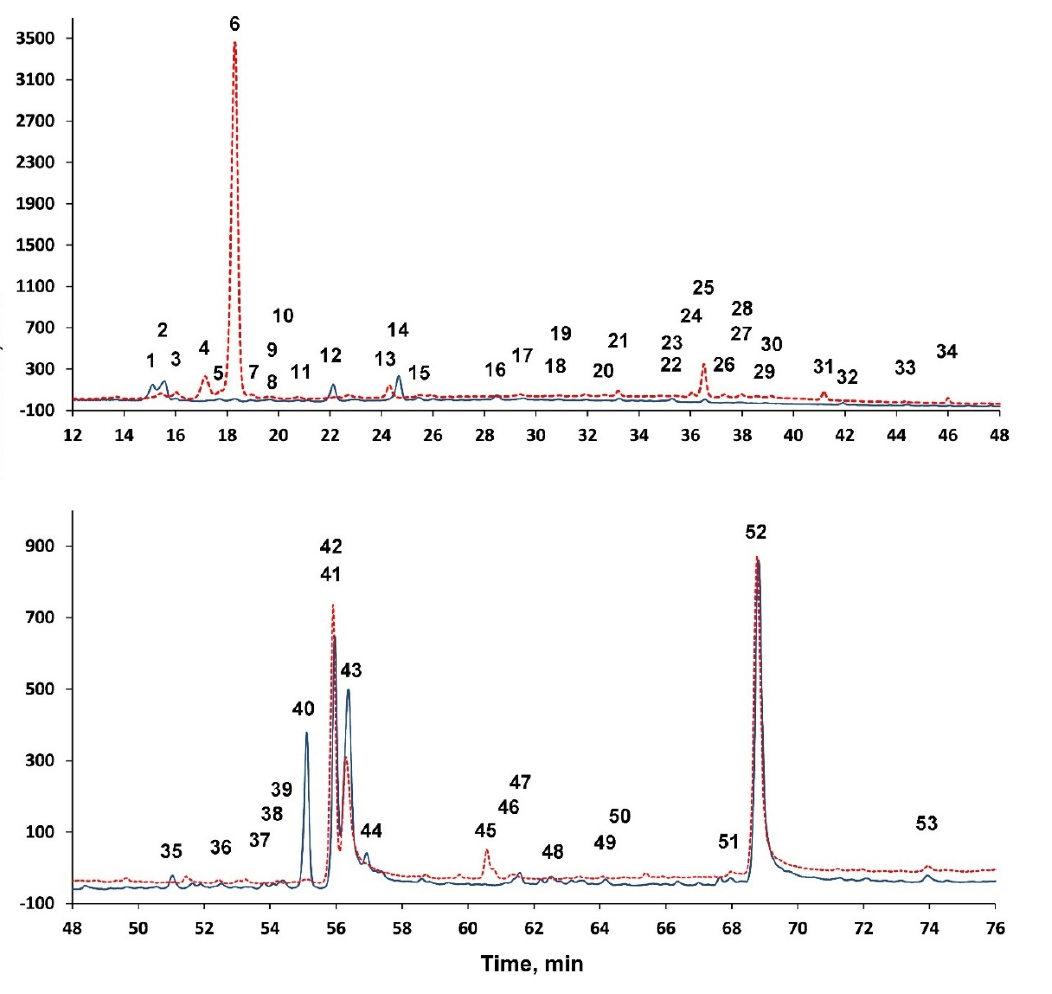
Figure 1. The HPLC-PDA (250–380 nm) chromatogram of Norway spruce (solid line) and eastern hemlock (dashed line) green cone extracts.